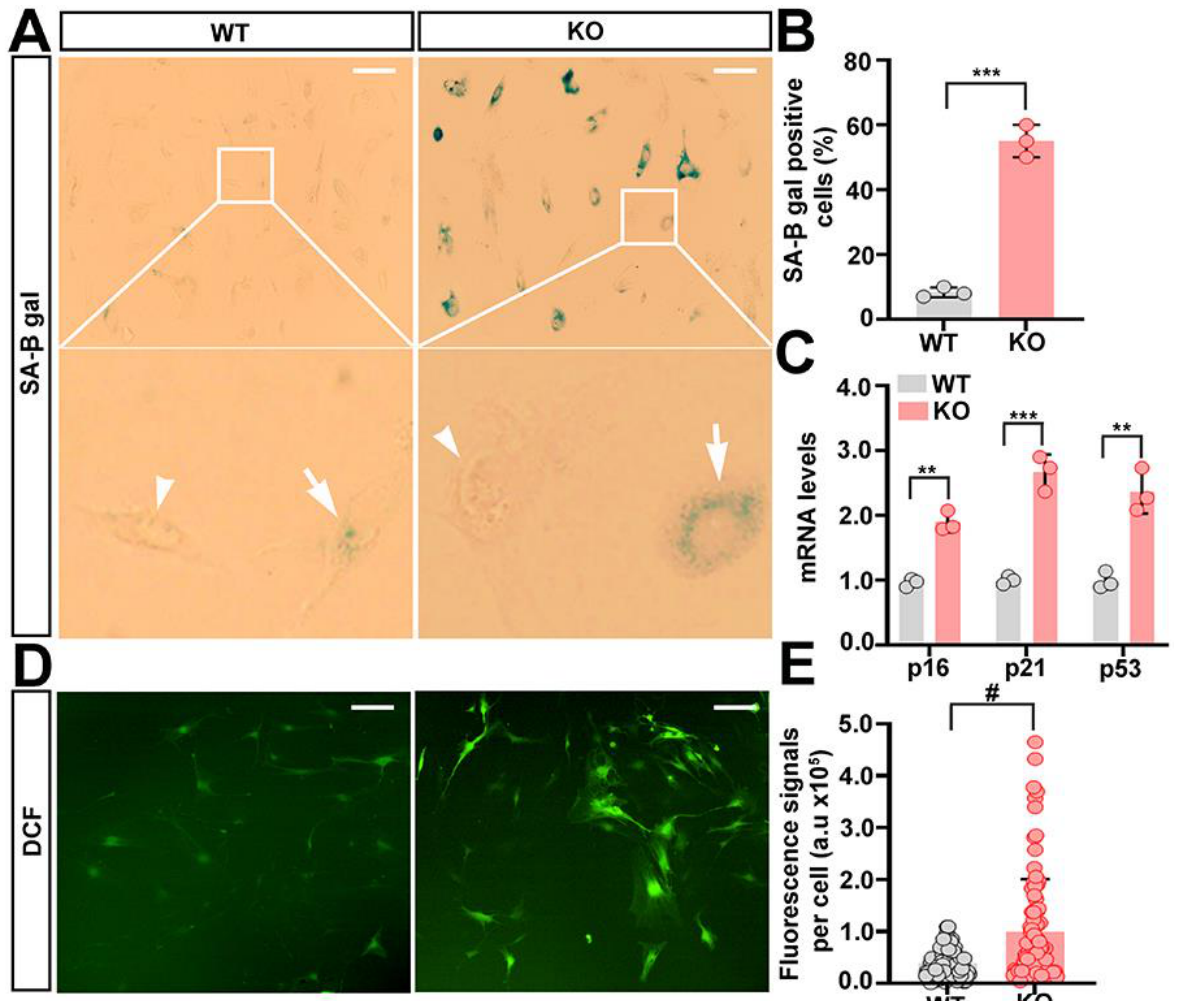
deposition in osteoblasts derived from WT ASCs; such string-like structures were twisted (blue arrowheads) in osteoblasts from trappc9-null (KO) ASCs. Scale bars: 100 µ m. Quantitative anal- ysis of cells stained with Oil red or with Alizarin red ( C ) as well as qPCR analysis of transcripts for adipogenic ( D ) and osteogenic ( E ) genes revealed that trappc9-deficient (KO) ASCs preferred adipogenic differentiation. In ( C ), average percentage of cells stained with oil red was graphed, whereas average calcified matrix nodules per well was counted and used as a measure of osteogenic differentiation. ( F ) Densitometry quantification of signals for oil red ( A ) or Alizarin red ( B ) showed that upon induction, cells derived from trappc9-null (KO) ASCs enriched more lipids and deposited minerals to a lesser degree than cells derived from WT ASCs. All experiments were repeated three times. Data are Mean ± SD. Unpaired two-tailed Student’s t -test: ** p < 0.01, *** p < 0.001, # p < 0.0001.